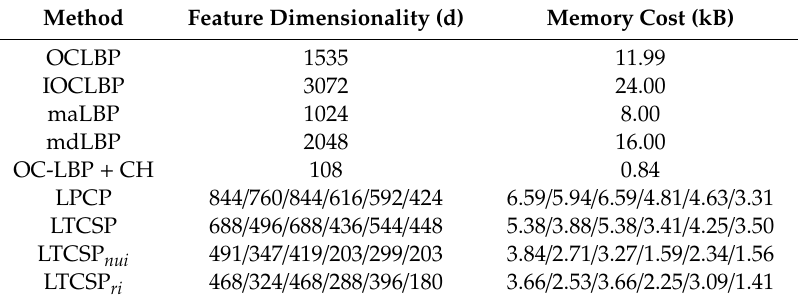
Table 6. Feature dimensionality (d) and memory cost (kB) among the proposed descriptors and six former